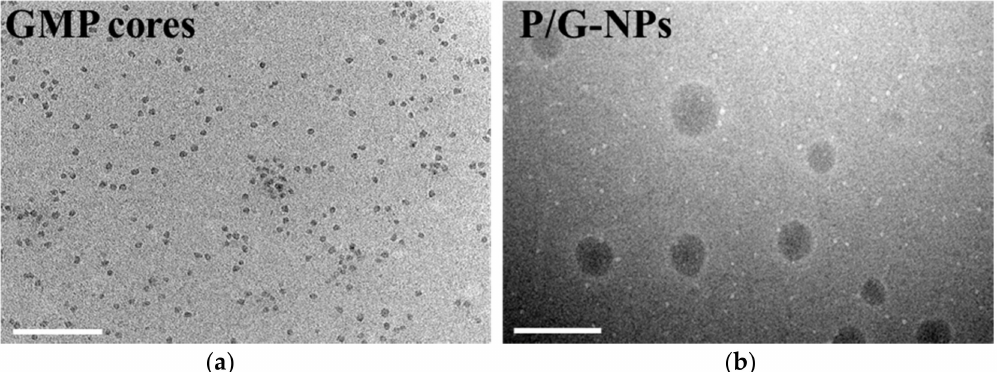
Figure 1. Morphological images: ( a ) gemcitabine monophosphate (GMP) cores; ( b ) lipid/calcium/ phosphate asymmetric lipid layer nanoparticles for the co-delivery of PTX and GMP (P/G-NPs). Bar equals 200